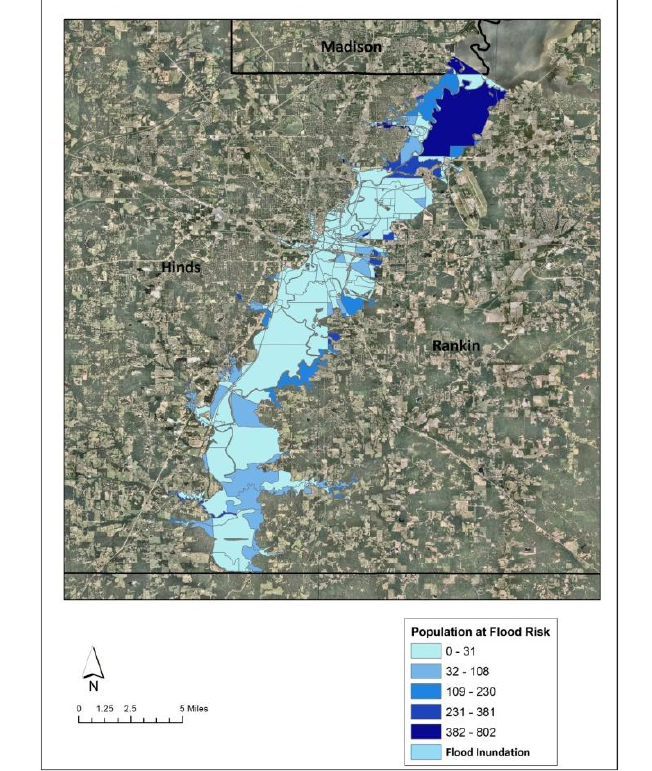
Figure 16. Population at flood risk downstream of Ross Barnett Reservoir.